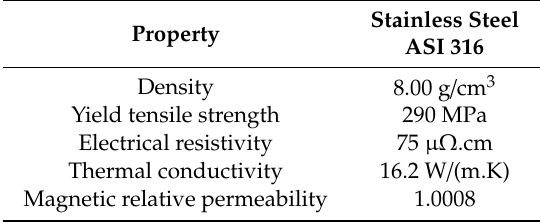
Table 3. Properties of stainless steel ASI 316.